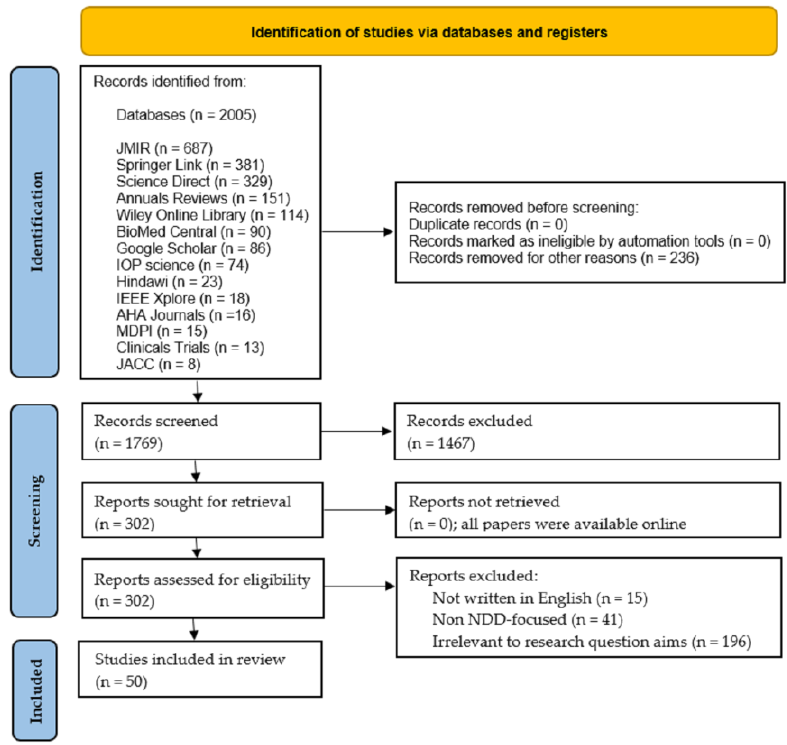
Figure 4. PRISMA flow diagram for the literature search.